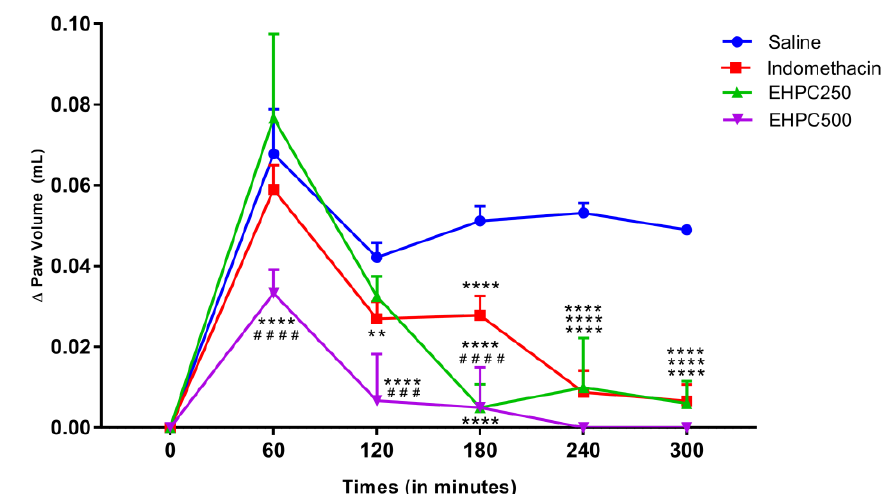
Figure 2. Carrageenan – Induced Paw Edema by subplantar administration of 1% carrageenan in orally treated mice with 0.9% NaCl, indomethacin 10 mg/kg, EHPC 250 and 500 mg/kg. ** p < 0.01; **** p < 0.0001 vs. CTRL; ### p < 0.001; #### p < 0.0001 vs. Indomethacin (ANOVA; Tukey).